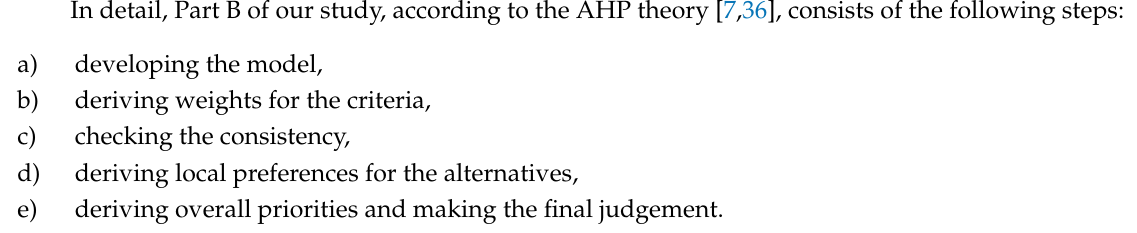
Figure 2. General scheme of the methodology for multicriteria analysis of mining waste potential of new use for the selected sites.